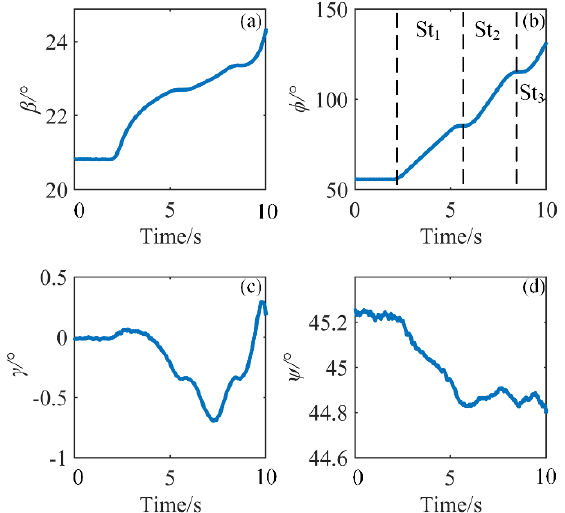
Figure 9 The measurands extracted from the Muller matrix in the oblique incidence experiments: (a) incident angle β over time; (b) the measured roll ϕ over time; (c) the optical rotation angle γ over time; (d) the polarimetric angle ψ over